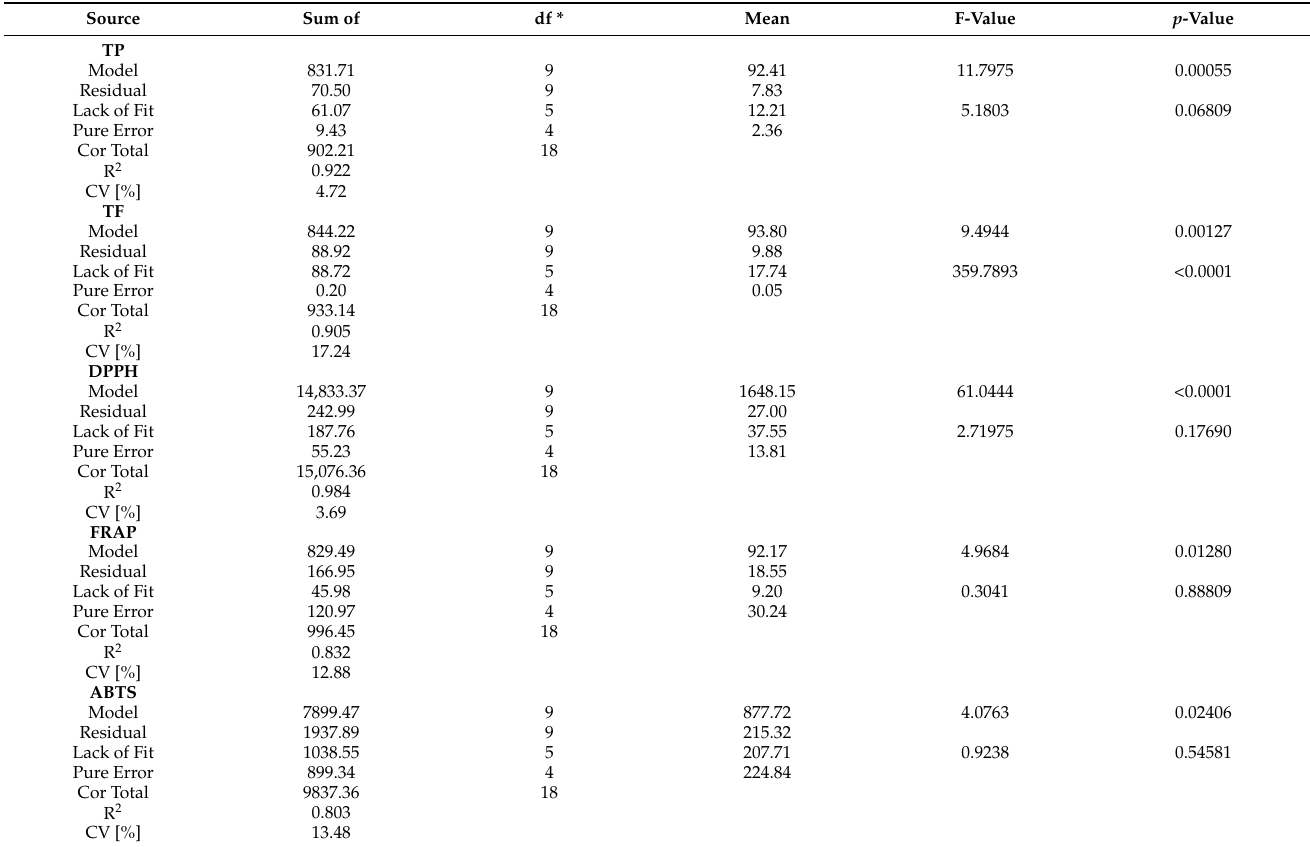
Table 3. Analysis of variance (ANOVA) and descriptive statistics (R 2 and CV) of the fitted model for all investigated responses (TP, TF, DPPH, FRAP and